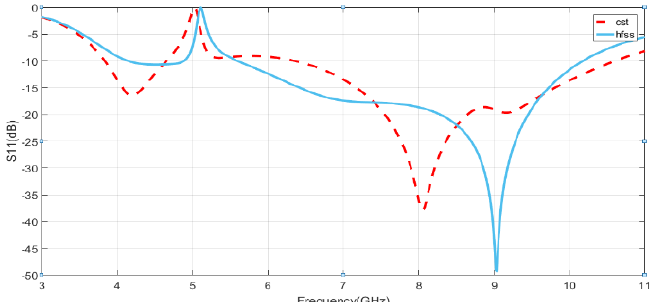
Figure4: Simulated reflection coefficient for various radius of DRA